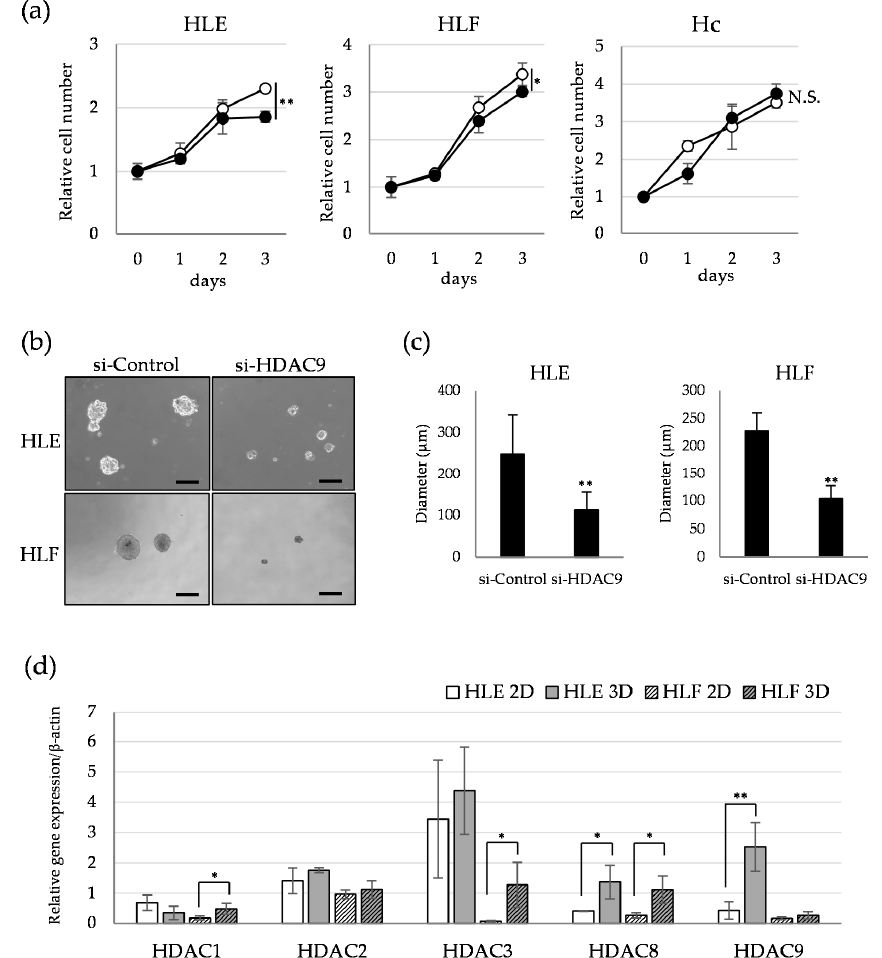
Figure 3. Involvement of HDAC9 in the sphere formation capacity of undifferentiated HCC cells. ( a ) Cell proliferation assays of HLE ( left ), HLF ( center ), and Hc ( right ) cells treated with si-Control (open circle) and si-HDAC9 (closed circle) for 3 days. Cell viability was determined by water-soluble tetrazolium (WST) assay and expressed as the relative amount of viable cells compared to day 0. * p < 0.05, ** p < 0.01 vs. si-Control group, N.S.: not significant, n = 3 ( b ) Morphological appearance of spheres formed in the culture medium containing 10 pmol / mL si-Control ( left ) and si-HDAC9 ( right ). HLE ( upper ) and HLF ( lower ) cells were cultured in an ultra-low attachment culture plate for 7 days and photographed. Scale bar = 200 µ m. ( c ) The diameter of the sphere was measured in ten representative spheres of each group. ** p < 0.01 vs. si-control. ( d ) Relative gene expression levels of HDAC1, HDAC2, HDAC3, HDAC8, and HDAC9 compared to a house keeping gene ( β -actin) were measured in 2D-(monolayer) and 3D-(sphere) cultured HLE and HLF cells by quantitative PCR analysis ( n = 4). * p < 0.05, ** p < 0.01 vs. 2D-cultured group. Quantitative PCR analysis was performed at n =